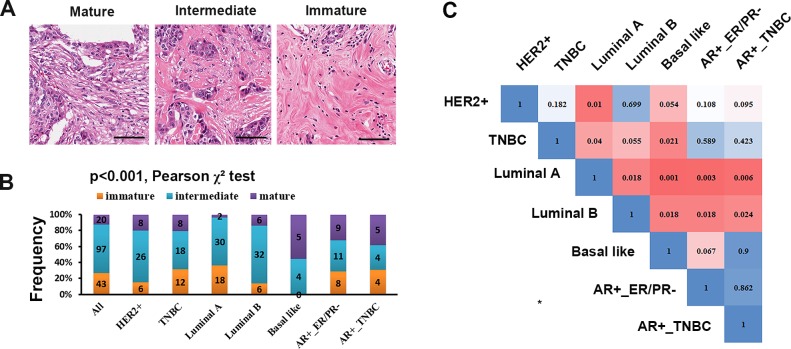
Fibrotic stromal types in different subtypes of breast cancer.(A) Maturation of breast cancer stroma. Scale bar: 50 μm. (B) Distributions of stromal types in different molecular subtypes of breast cancer. The number in the histogram bar indicated the number of cases. Multiple comparison among different molecular subtypes was performed by Pearson χ2 test. (C) Differences between each other of stromal types constitution among seven molecular subtypes indicated by p values. The blue to red gradient ramp indicates a p value from 1 to 0.001. The comparison between each molecular subtype was conducted by Pearson χ2 test and corrected by Bonferroni correction. Because of 21 comparisons between each other among seven molecular subtypes, differences were considered significant when the Bonferroni correction p value less than 0.0024 (0.05/21).